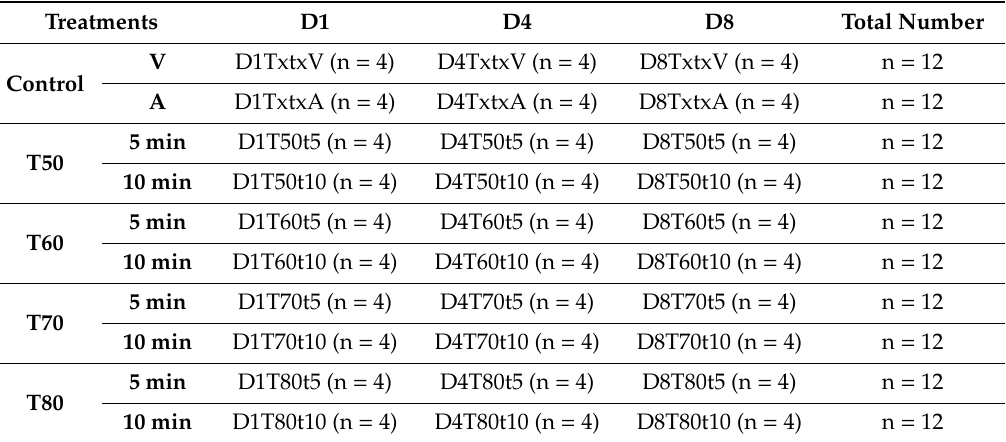
Table 1. Summary of the experimental